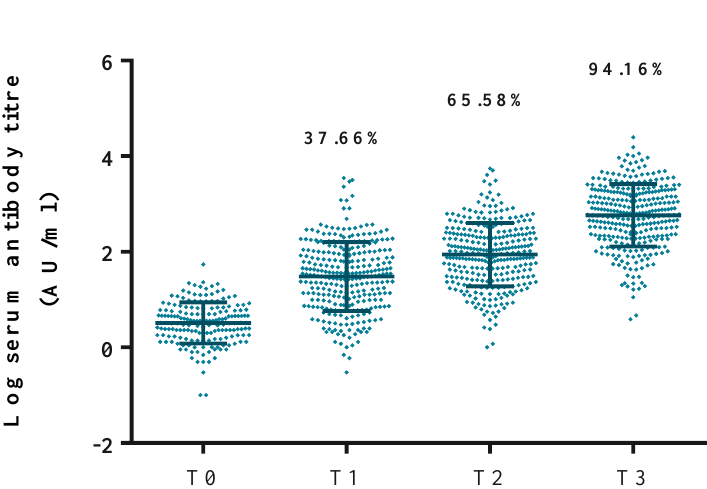
Figure 1. Log10 value of antibody titers against the RBD of the S1 subunit of the SARS-CoV-2 spike protein in arbitrary units (AU)/mL. Data on the graph represents the percentage of participants’ antibody titers greater than 50 AU/mL. Abbreviation: RBD, receptor-binding domain.